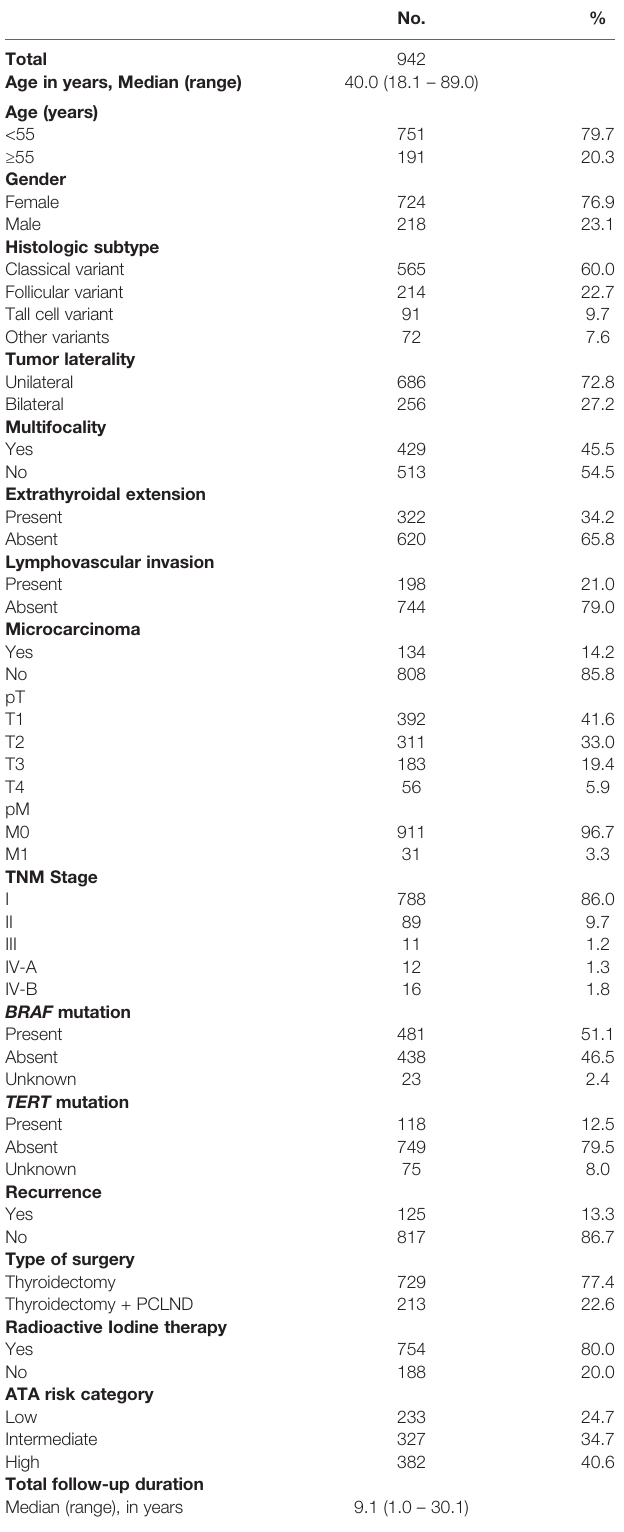
TABLE 1 | Clinico-pathological and molecular characteristics of adult papillary thyroid carcinoma.